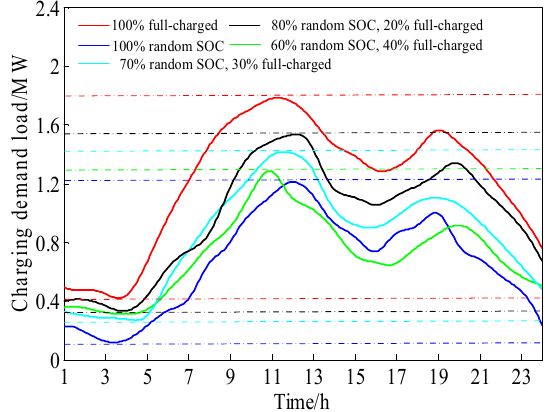
Figure 17. Charging demand load for different charging modes. Table 3. Comparison of service indicators of different charging modes.